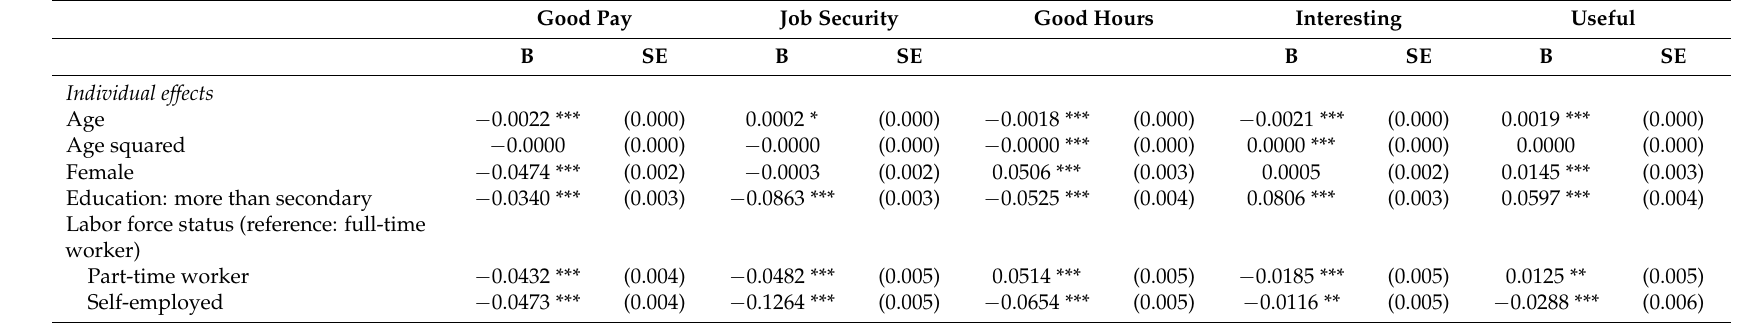
Table A12. The HAPC models of the importance of work values, with control